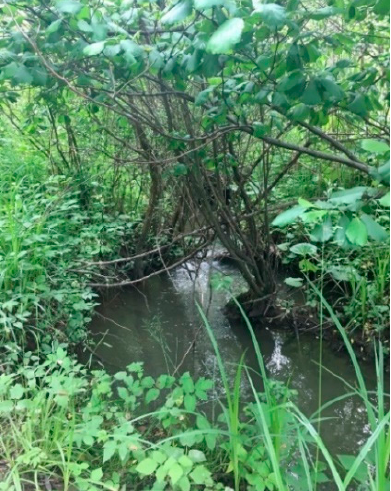
Atmosphere 2021 , 12 , x FOR PEER REVIEW Figure 13. Fel ţ a River refuge habitat. Figure 13. Fel¸ta River refuge habitat.